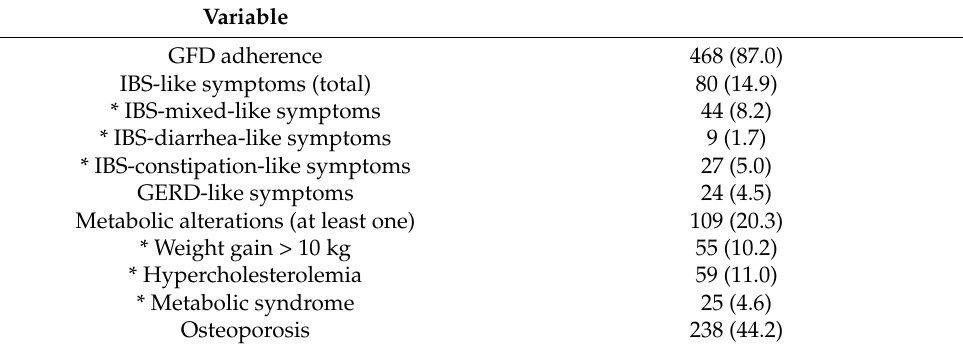
Table 2. Events occurring during follow-up of CD patients who did not drop out in the first 6 months ( n = 538). Variables are expressed as frequencies (percentage).